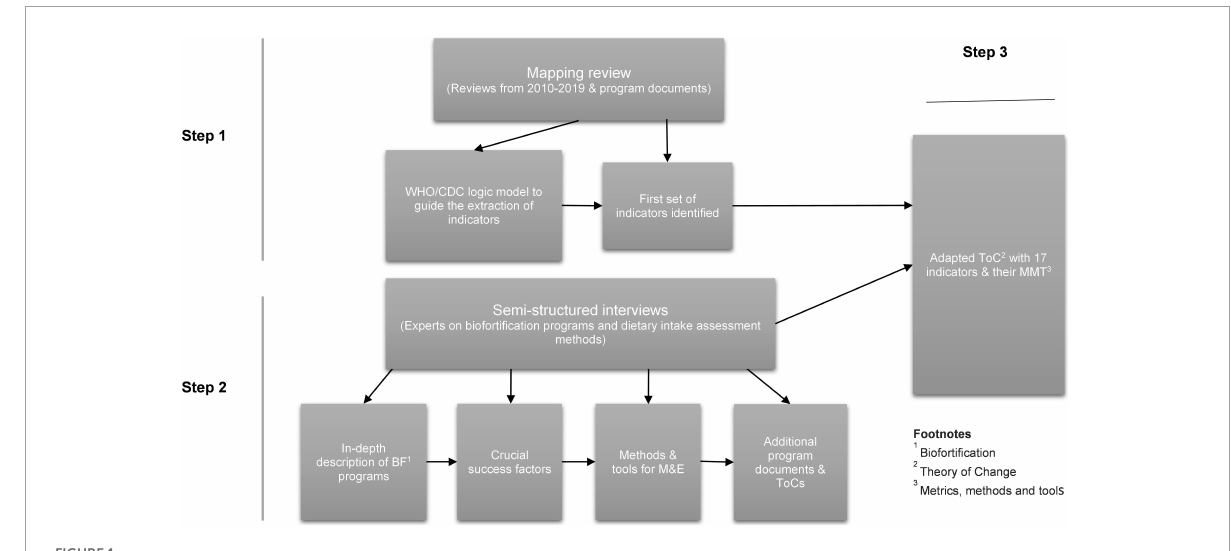
FIGURE1 Overview of the multi-phase, iterative process research approach.